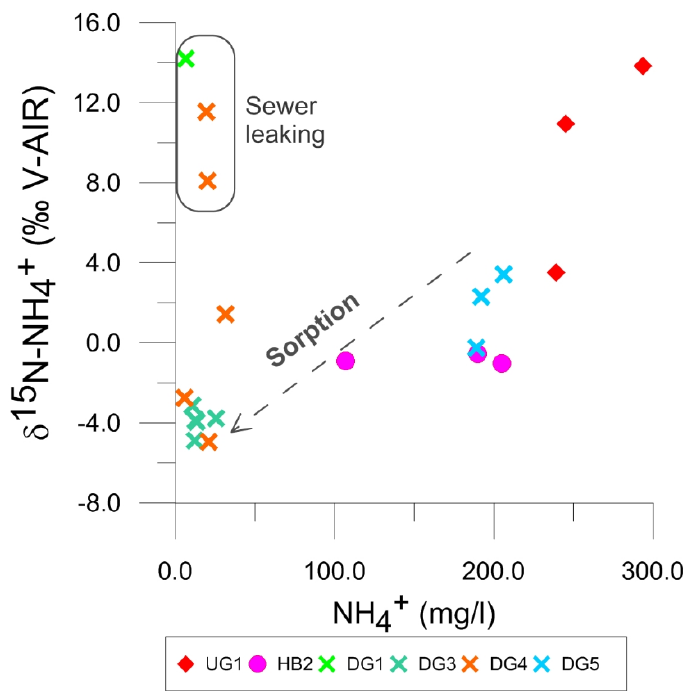
Figure 5. Diagram of δ 15 N – NO 3 − versus δ 18 O – NO 3 − in samples analysed from MLS located upgradient (UG2) and downgradient (DG1, DG4 and DG5) with respect to the hydraulic barrier (see Figure 1 for sampling site location). Modified from Clark and Fritz [44].